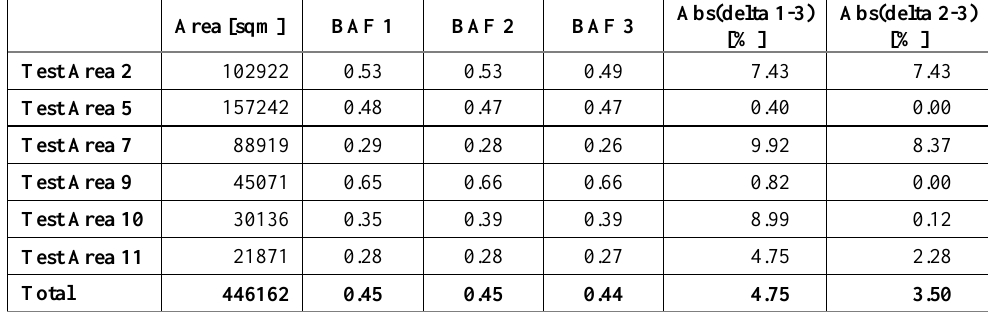
Table 6. Final results for the six test areas and for all the three levels